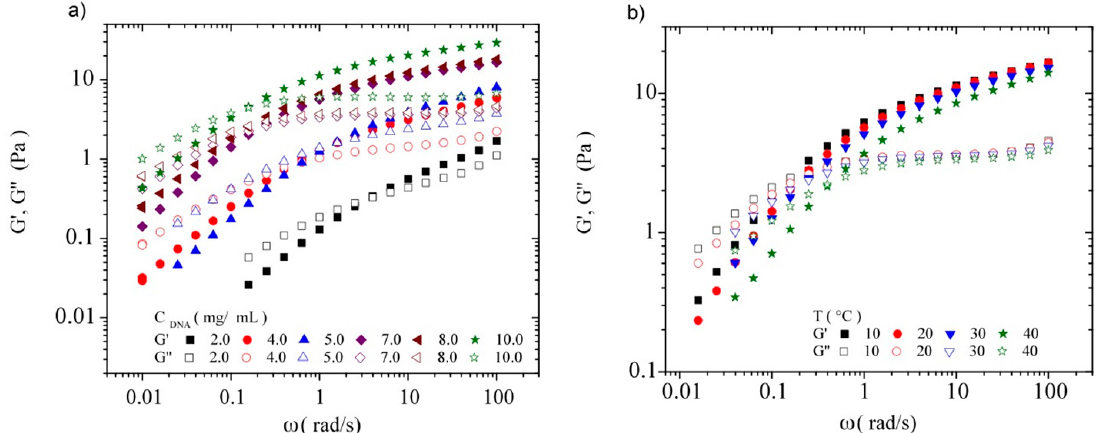
Figure 14. Frequency dependence of the storage (G’) and the loss modulus (G”) for ( a ) different C DNA in TE buffer at 10 °C and for ( b ) a C DNA of 7 mg/mL in TE buffer at 10, 20, 30, and 40 °C.